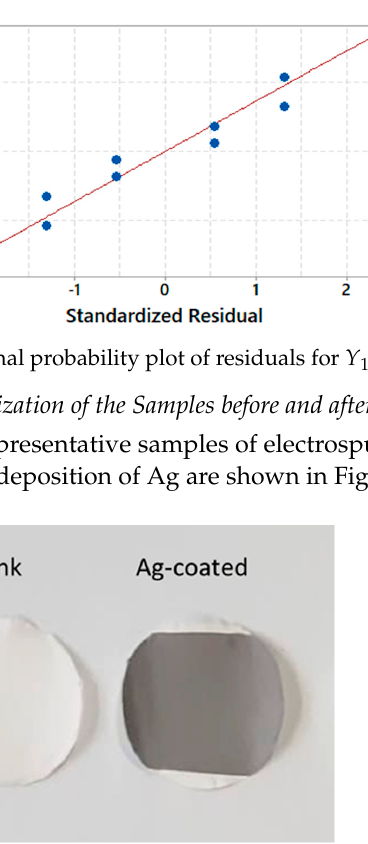
Figure 4. Representative samples of electrospun blank ( left ) and Ag-coated ( right ) PSU disks. The morphology of the PSU disks before and after the Ag treatment was investigated using SEM. Micrographs at low magnification (Figure 5) show that the membranes are composed of a dense net of randomly oriented fibers. The diameter of the fibers is broadly distributed from 100 nm or less to a few microns. The diameter distributions, as deter- mined by fiber counting on SEM micrographs, were 0.82 ± 0.45 μ m and 2.24 ± 1.27 μ m for DOE3 and DOE7, respectively (mean values ± MSE).